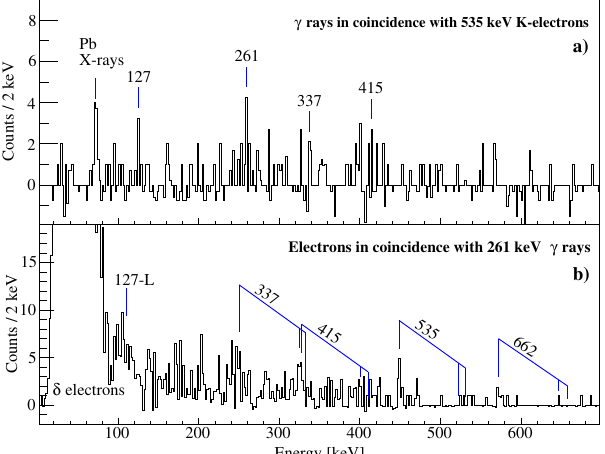
Fig. 4 Evidence for the de-excitation path passing through the 0 þ state. 2 a Recoil-gated, α -tagged background subtracted γ -ray energy spectrum with a gate on the K-electrons of the 535 keV transition. b Recoil-gated, α - tagged background subtracted electron energy spectrum with a gate on the 261 keV γ rays. The peaks associated with 186 Pb have been labelled with corresponding transition energies and positions of the K-, L- and M-conversion components are marked. The position of the L-electron ! 0 þ component of the 2 þ transition (113 keV) is marked for visualisation. 1 2